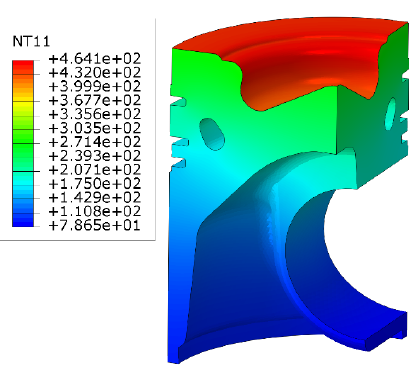
Fig. 5. Temperature field of the uncoated piston